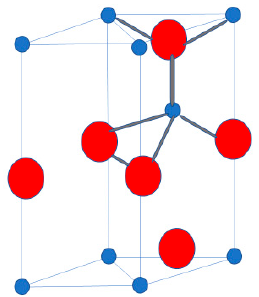
Figure 2. Wurtzite Structure of Zinc